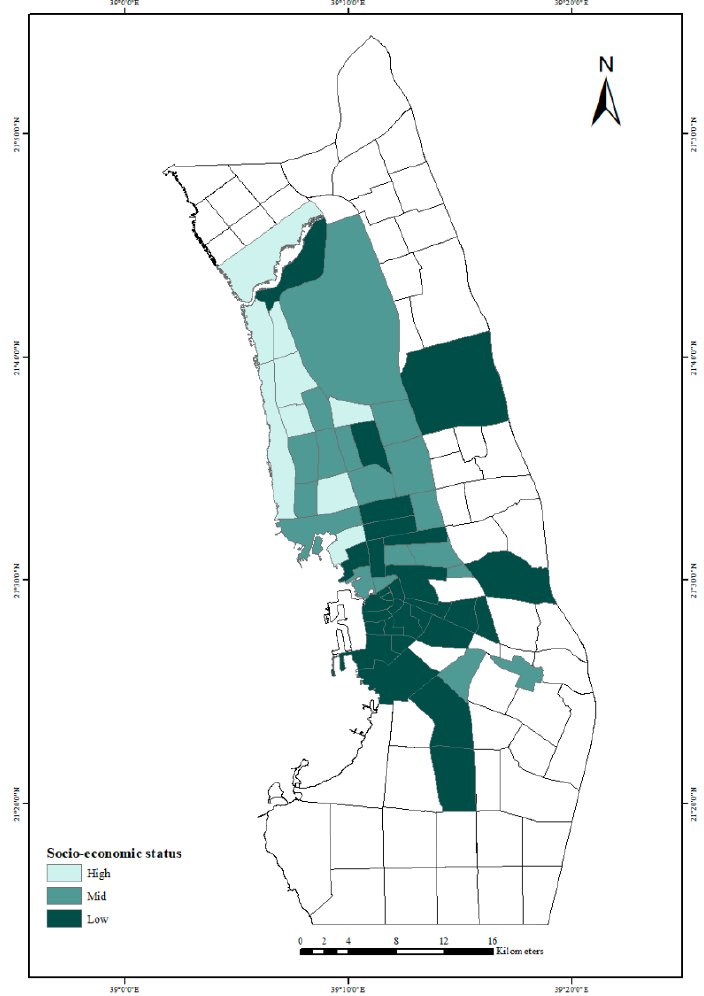
Figure 1. Socio-economic status of neighborhoods in Jeddah City.